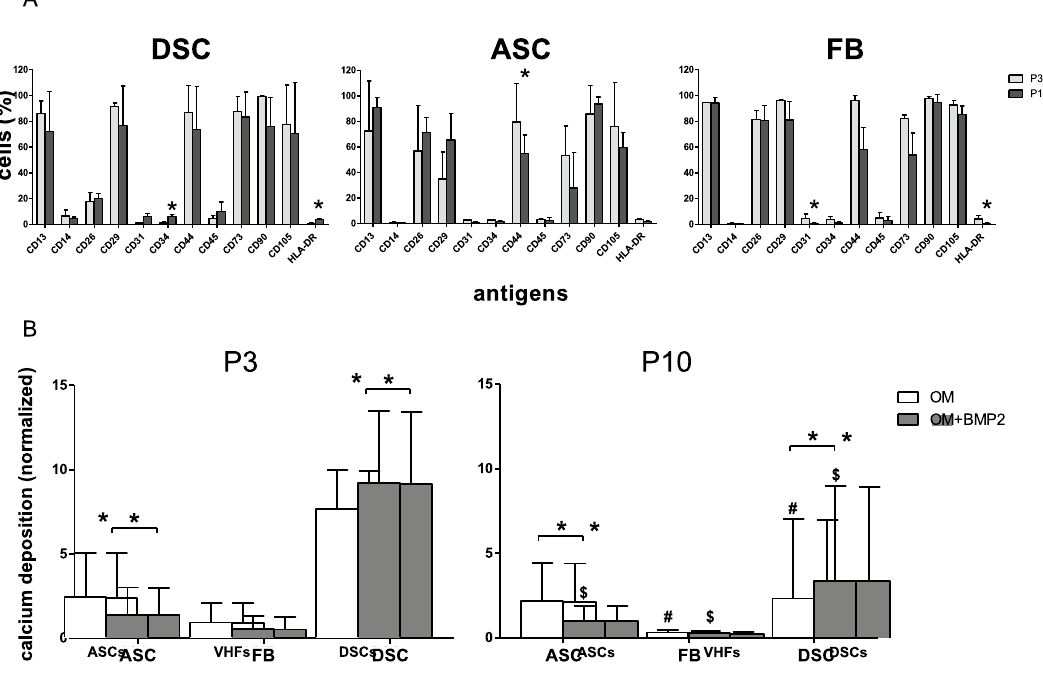
Figure 1. ( A ) Phenotype characterization. Phenotype characterization of human DSC, ASC, and FB cultures in P3 (grey bars) and P10 (black bars) was performed by FACS analysis. Bars represent mean ± SD of three donors. *, p < 0.05 as compared to the respective sample of the culture of P10. ( B ) Comparison of the osteogenic differentiation +/− BMP-2 between P3 and P10. The osteogenic differentiation potentials of DSC, ASC, and FB. DSC and ASC at P3 had the best potential to differentiate osteogenically compared to FB. Only in DSC the osteogenic differentiation could be significantly improved with BMP-2. In a comparison of P3 to P10 cells, DSC showed the greatest decrease, and ASC showed the smallest decrease in osteogenic differentiation potential compared to their younger counterparts at P3. White bars demonstrate the osteogenic differentiation with standard osteogenic differentiation media (OM). Grey bars demonstrate the osteogenic differentiation media supplemented with BMP-2 (OM + BMP2). Bars represent mean ± SD of six donors. * p < 0.05 as compared to the respective sample cultured with OM. #,$ p < 0.05 as compared to the respective sample in